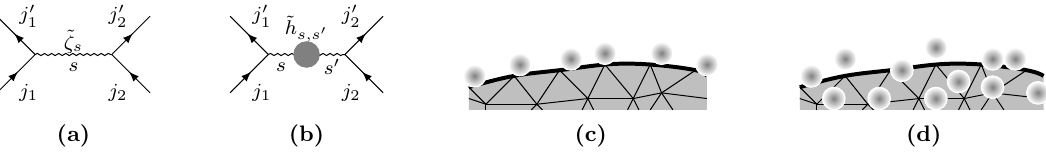
Figure 3. The e(cid:11)ective anyon interaction due to (a) ~ (cid:16) s in eq. (6.2) that conserves anyon charge. (Note that the (cid:12)gure is not perturbative Feynnman diagram in our context, where all calculation is non-perturbative.) (b) ~ h s;s 0 in eq. (5.10) that does not conserve anyon charge because s 6 = s 0 generally. (c) The unconservation is due to bulk-boundary anyon charge exchange. (d)